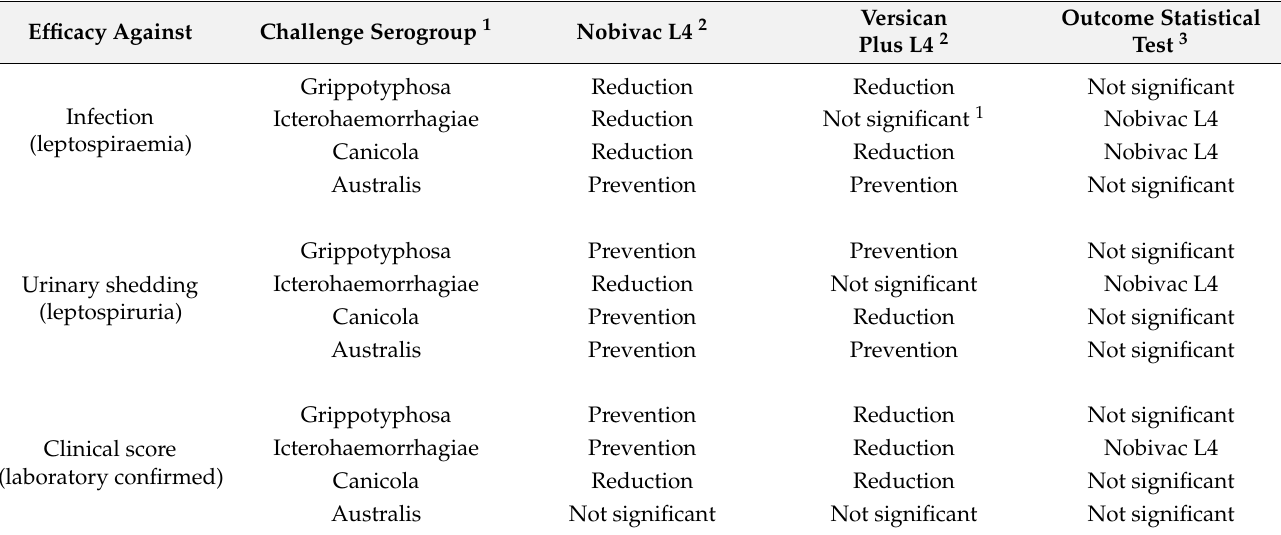
Table 5. Summary of comparative efficacy of the two vaccines in the present four